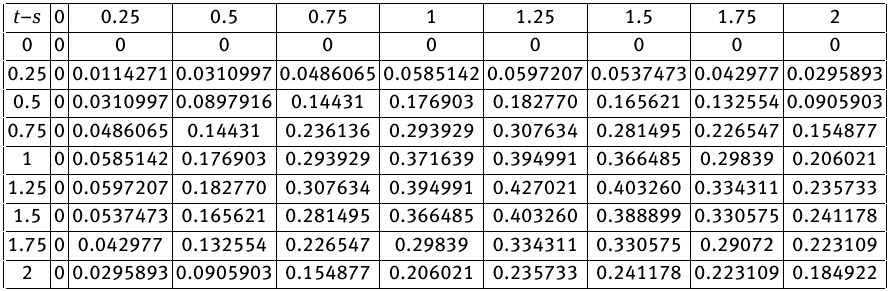
Table 9: Approximation of C ov[ X ( t ), X ( s )] via adapted gPC with p = 7 . Example 4.2, assuming independent random